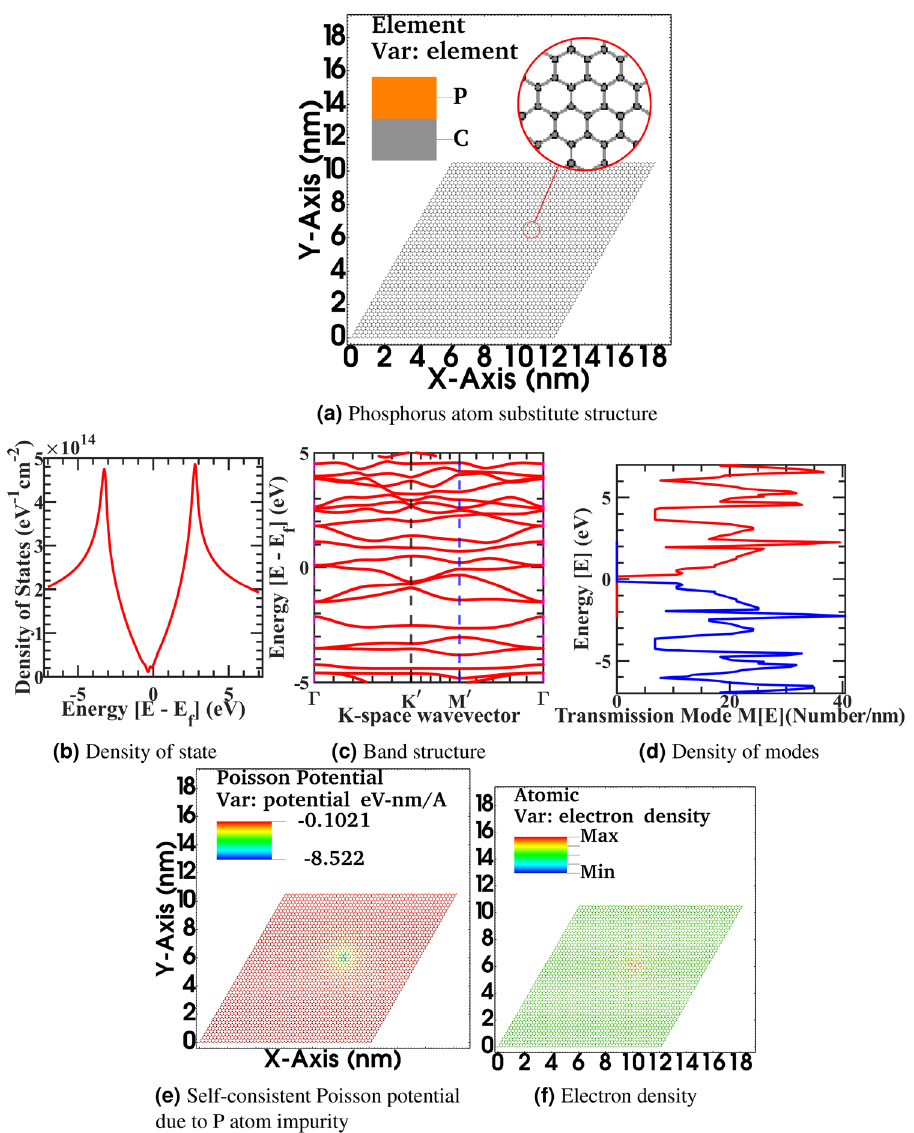
Figure 9. Primitive device structure 50 x 50 graphene supercell with substitutional phosphorus impurity with ten electronic charge ( a ), Density of state ( b ), Electronic band structure ( c ), Density of modes ( d ), Self- consistent Poisson potential due to Phosphorus impurity ( e ), Electronic density ( f